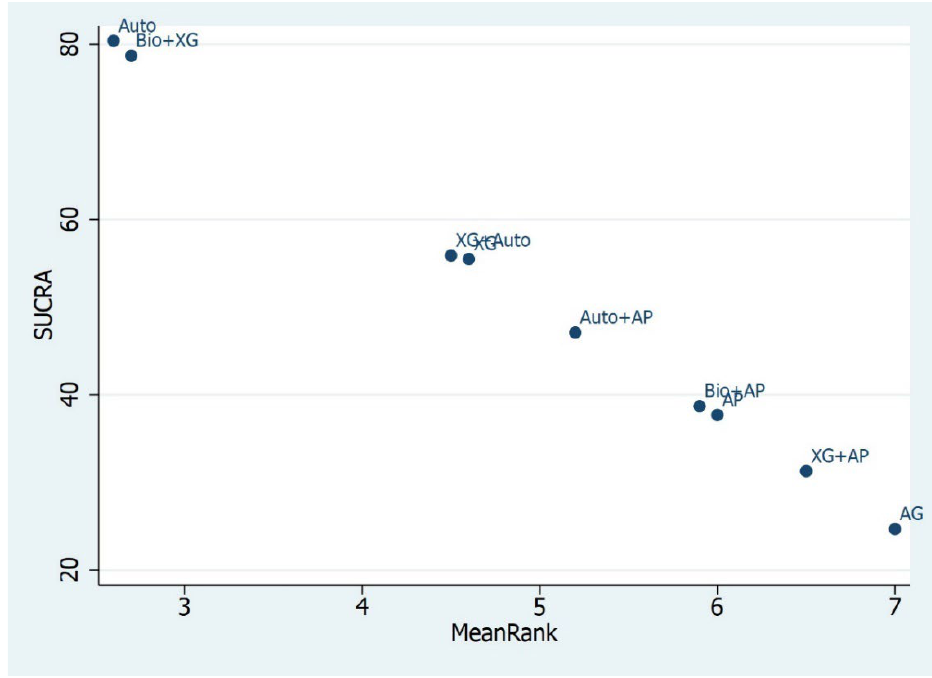
Figure 5. SUCRA Ranking for ≥ 4 mm RBH. Auto and Bio+XG ranked first, AG ranked last. Quality of Evidence